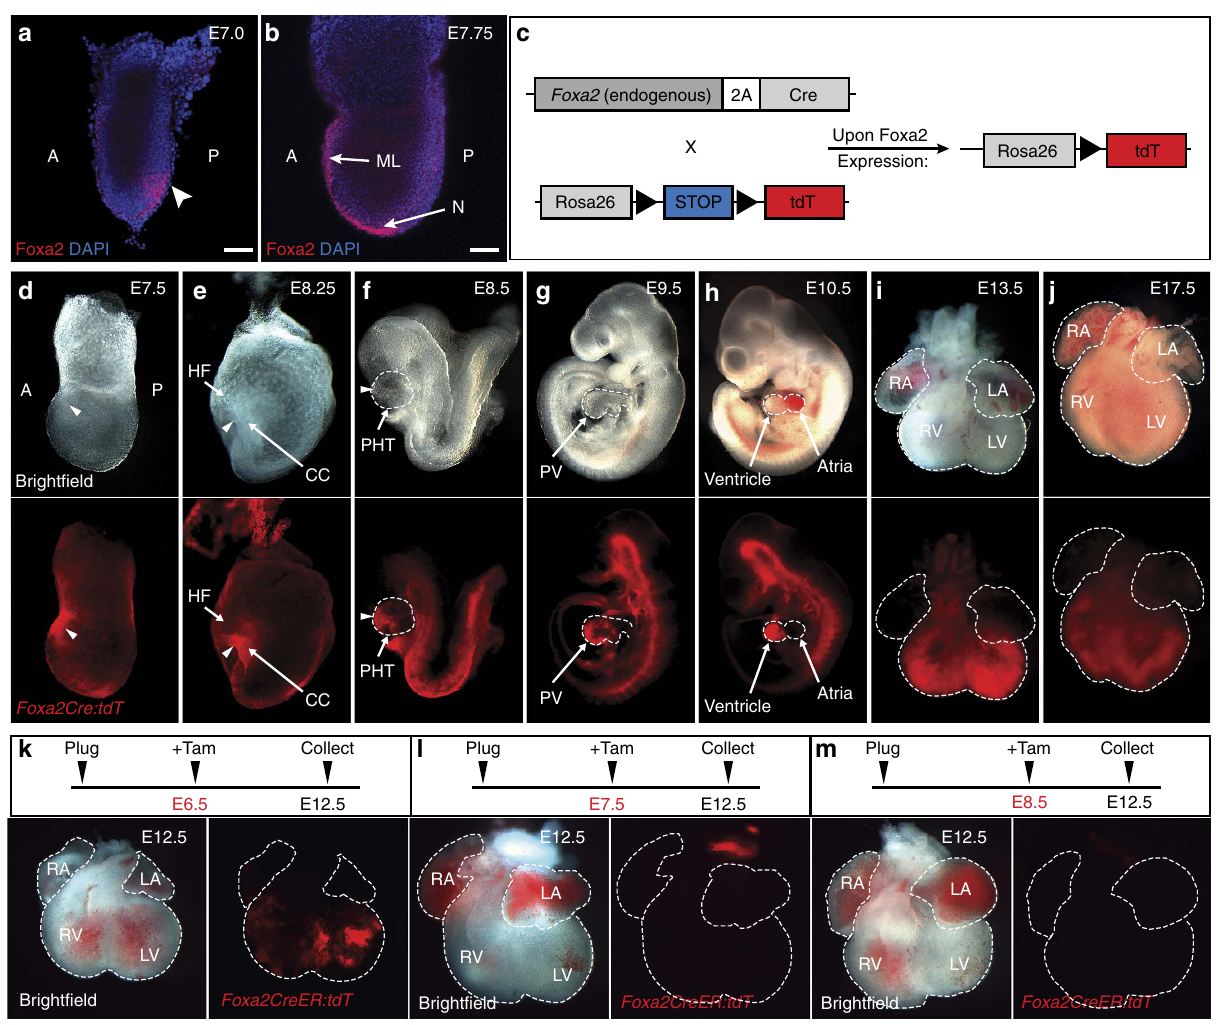
Figure 1 | Lineage tracing of Foxa2-expressing cells during mouse development. ( a , b ) Representative confocal images of WMIF of E7.0 ( a ) and E7.75 ( b ) embryos with antibodies against Foxa2. Embryos were counterstained with 4,6-diamidino-2-phenylindole (DAPI) to label nuclei. Arrowhead shows the presumptive cardiogenic region of the PS. Scale bars, 75 m m. ( c ) Schematic of the Foxa2 lineage-tracing system that results in permanent labelling of all cells that express Foxa2 during development. ( d – j ) Whole-mount imaging of Foxa2Cre lineage-tracing embryos ( d – h ) or dissected hearts ( i , j ). Foxa2Cre embryos crossed with R26-tdT show labelling of the ventricular portion of the developing heart tube and heart. ( k – m ) Whole-mount imaging of dissected hearts of Foxa2CreER ; tdT embryos. Tam (0.05mgg (cid:2) 1 ) was injected at E6.5 ( k ), E7.5 ( l ) or E8.5 ( m ) and embryos were collected at E12.5. Dashed lines outline the heart tube ( f – h ) or the heart chambers ( i – m ). A, anterior; CC, cardiac crescent; HF, head folds; LA, left atria; LV, left ventricle; ML, midline; N, node; P, posterior; PHT, primitive heart tube; PV, primitive ventricle; RA, right atria; RV, right